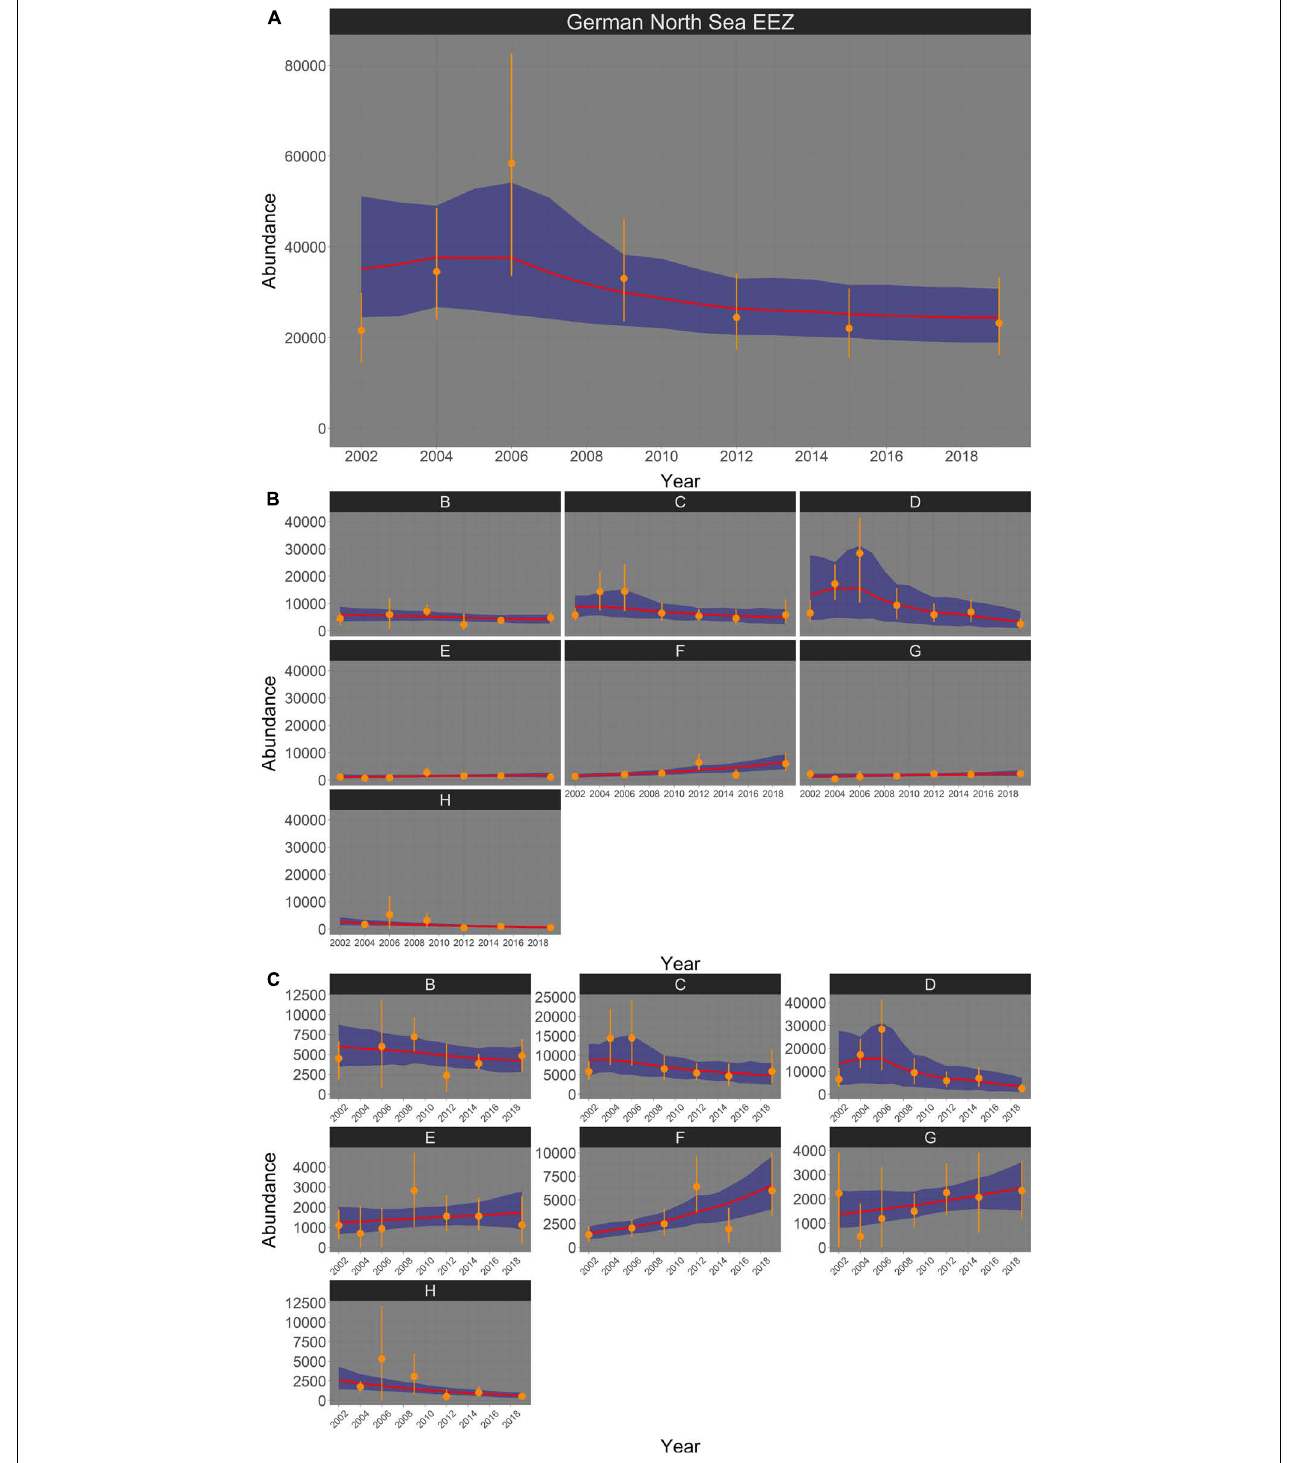
FIGURE 5 | Bayesian abundance trend analysis for harbor porpoises in the German North Sea EEZ (aggregated trend) (A) and for each stratum separately (B,C) based on post-stratified aerial survey data in summer, between 2002 and 2019. Only years are included when the complete study area was covered (excluding Dogger Bank stratum A). Orange dots illustrate stratum-based abundance estimates and orange lines represent the associated 95% CI. The red line shows the median of the posteriori distribution of the calculated “true” abundances from the Bayesian model, the blue shaded area displays the corresponding 95% credibility intervals. Please note that all sub-figures in (B) share a common y -axis, while the y -axis is free in (C) .